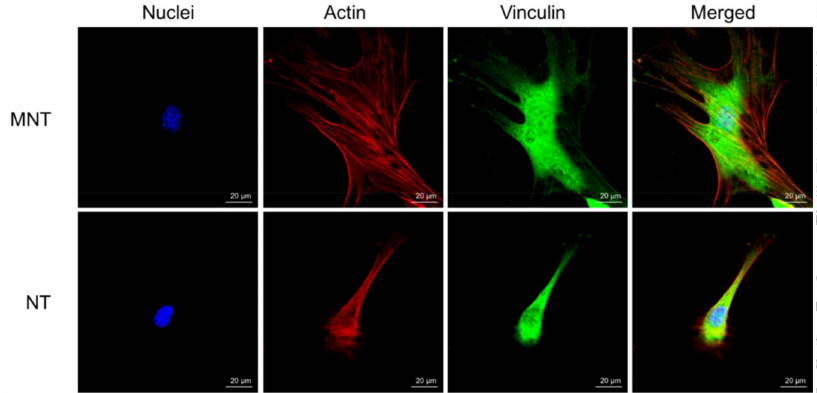
Figure 10. Fluorescence staining images of MC3T3 cells after 4 days on different coatings. Blue, nuclei; Red, actin; Green, Vinculin. “Merged” represents the merged pictures of the above three